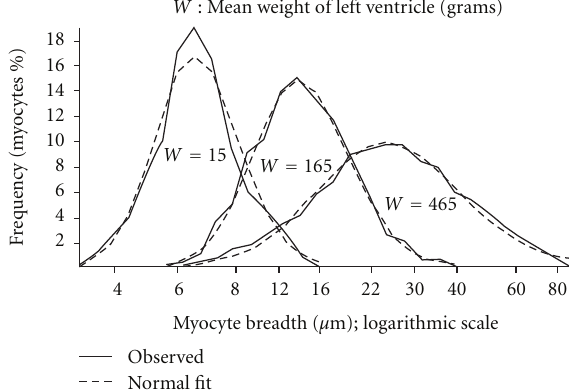
Figure 2: Observed frequency distributions and their log normal fitted curves for a 6-week-old infant ( W = 15) and two selected pools of left